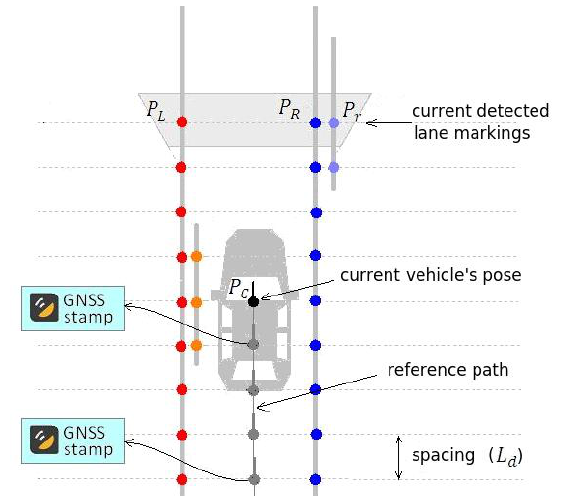
Figure 23. Data structure: Sampling the i-th position and lane markings information in the longitudinal discrete